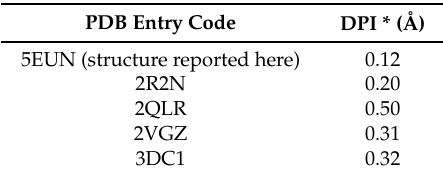
Figure 4. ( a ) The binding cup interactions of the phosphate group of LLP in the resting state of hKAT-II. The phosphate of LLP forms polar interactions with the residues Gly116, Ser117, Gln118, Ser262 and Arg-270; ( b ) Hydrophilic (hydrogen bond) interactions of Tyr233 and Asn202 with the pyridoxal ring of LLP, as well as polar interactions of Asp230 with pyridine nitrogen of LLP, which is a characteristic of the fold type-I of the PLP-dependent enzyme family. The hydrophobic interactions are with the sidechains of Tyr142 and Pro233, highlighted by red arrows. Hydrogen bonds are all represented with black broken lines. Table 1. The diffraction precision index (DPI) of hKAT-II PDB entries.